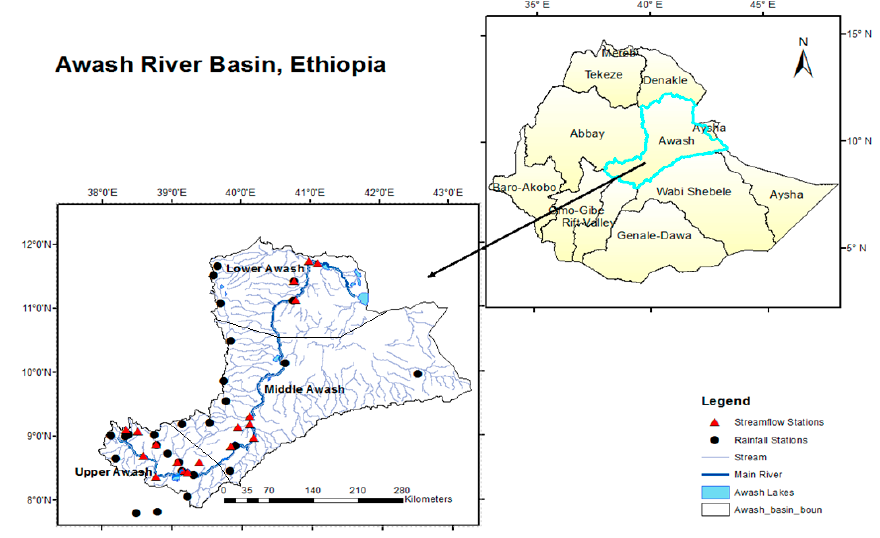
Figure 1. Location of the study area .